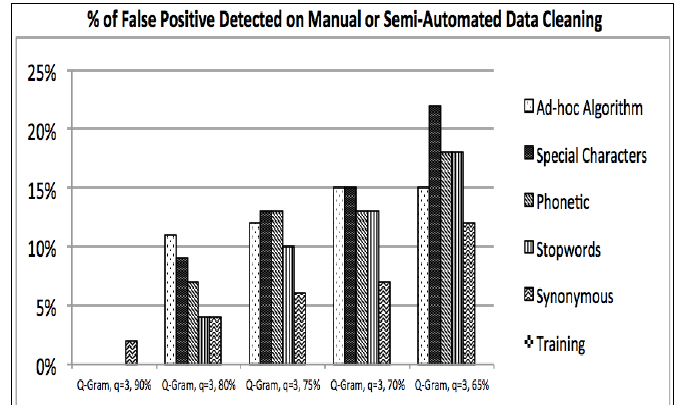
Figure 9: Percentage of false-positives detected in manual data cleaning process.